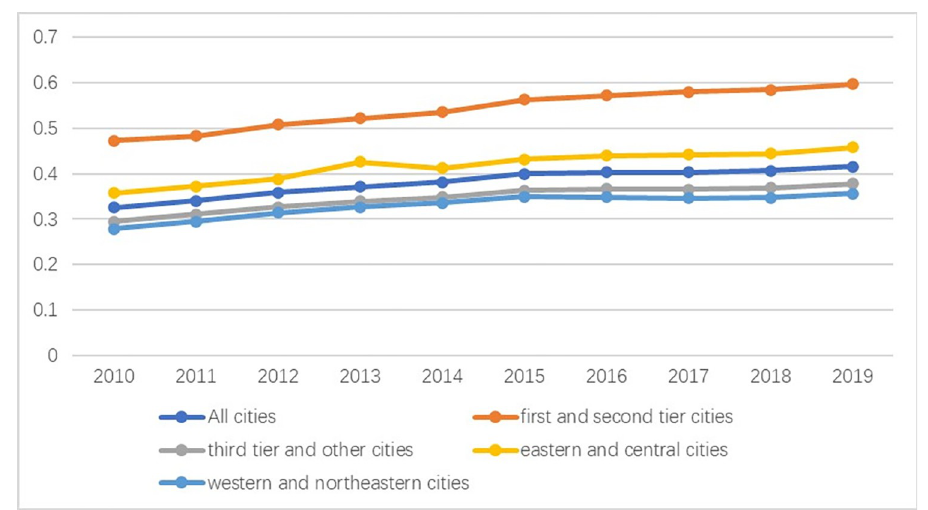
Fig 3. Cities’ degree of coupling of the digital economy, industrial structure supererogation and pollution